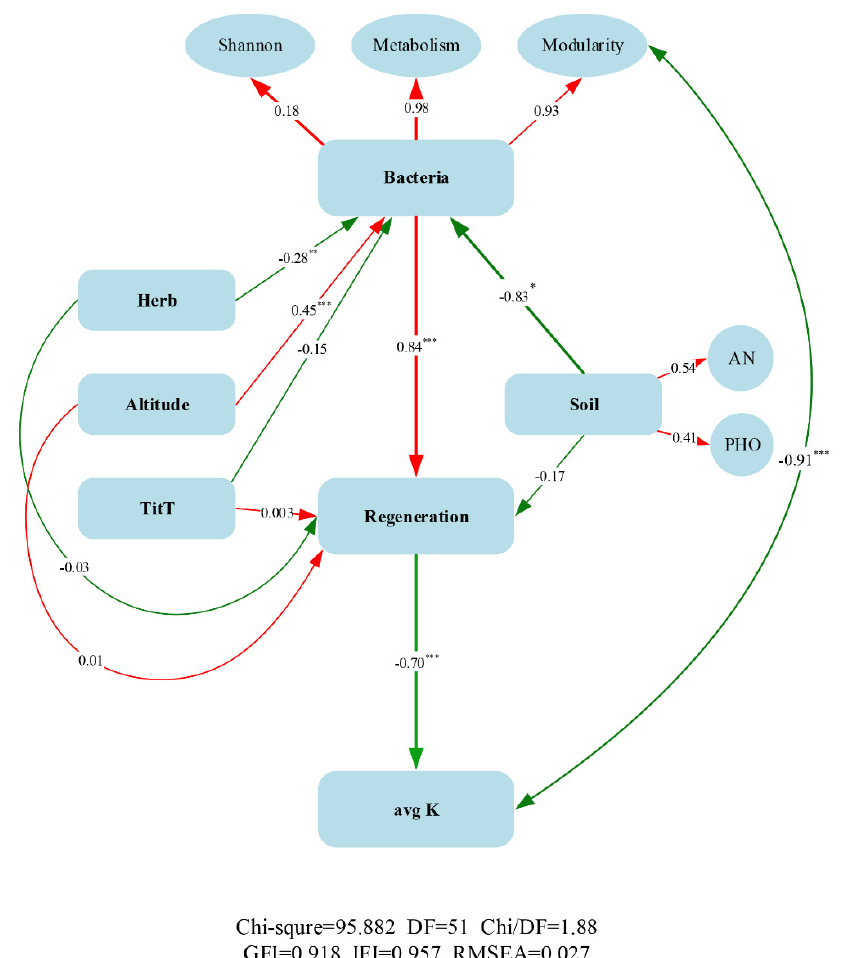
Figure 6. A structure equation model established to explore the significant effects of bacterial community composition (Shannon index, metabolism, modularity), complexity of co-occurrence network (avg K), herb diversity (H. Simpson), Altitude, Dead branch and leaf layer (Tit T), Soil nutrients (AN, PHO) and stand regeneration (the number of regenerated plants). Note: *** represents a significant correlation of p < 0.001. ** represents a significant correlation of p < 0.01. * represents a significant correlation of p < 0.05.